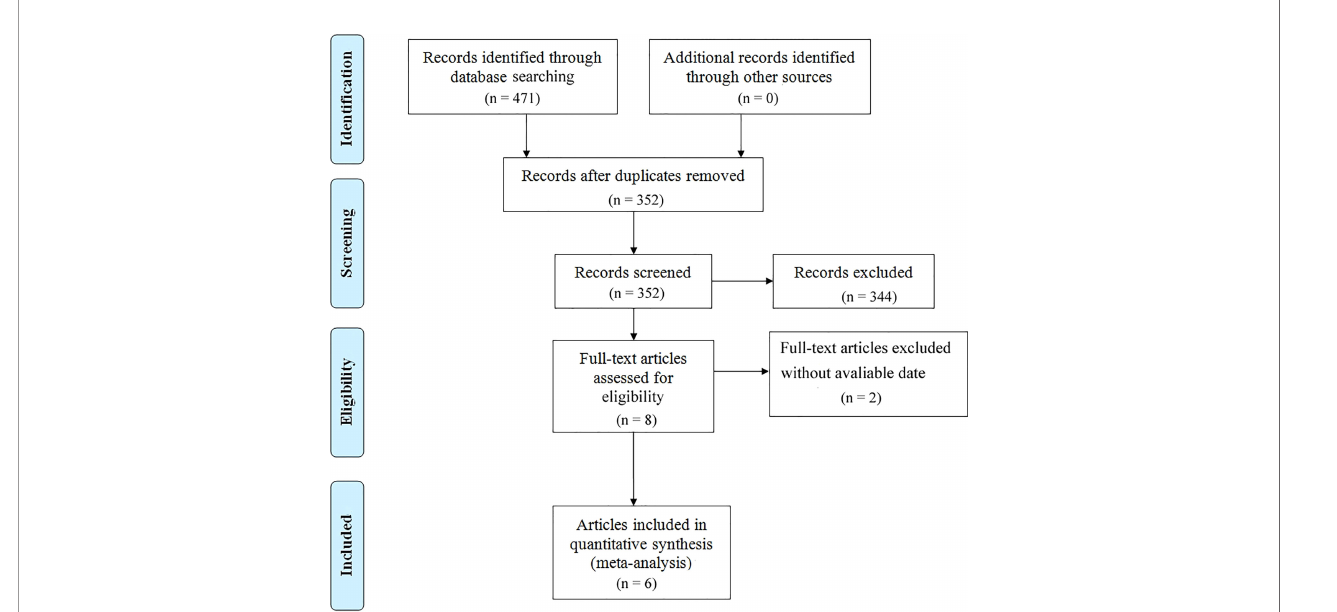
FIGURE 1 | Flow chart of the